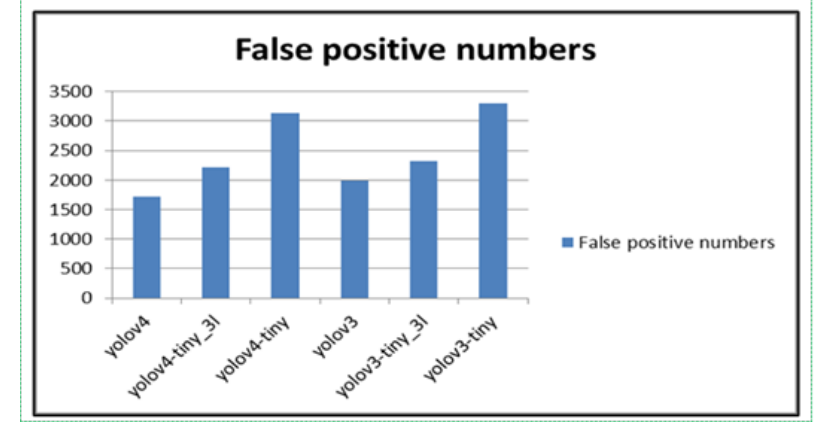
Figure 9. First experiment’s weighted file results on false-positive tests.